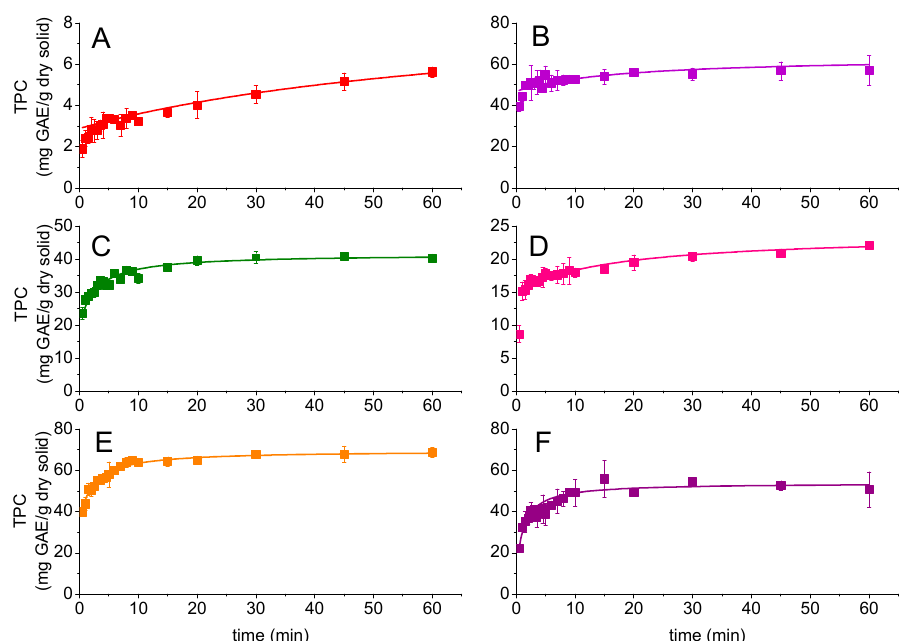
Figure 7. Kinetic analysis of the extraction process from grape pomace (GP) with a hydroalcoholic solution (ethanol/water 70%/30% v/v ) at several temperatures: ( A ) 25 °C, ( B ) 50 °C, ( C ) 70 °C, and ( D ) 90 °C. Data, in points, reflects the total phenolic content (TPC) obtained by the Folin–Ciocalteu method. The lines indicate the fitting of the second-order kinetic model presented in Equation (1).